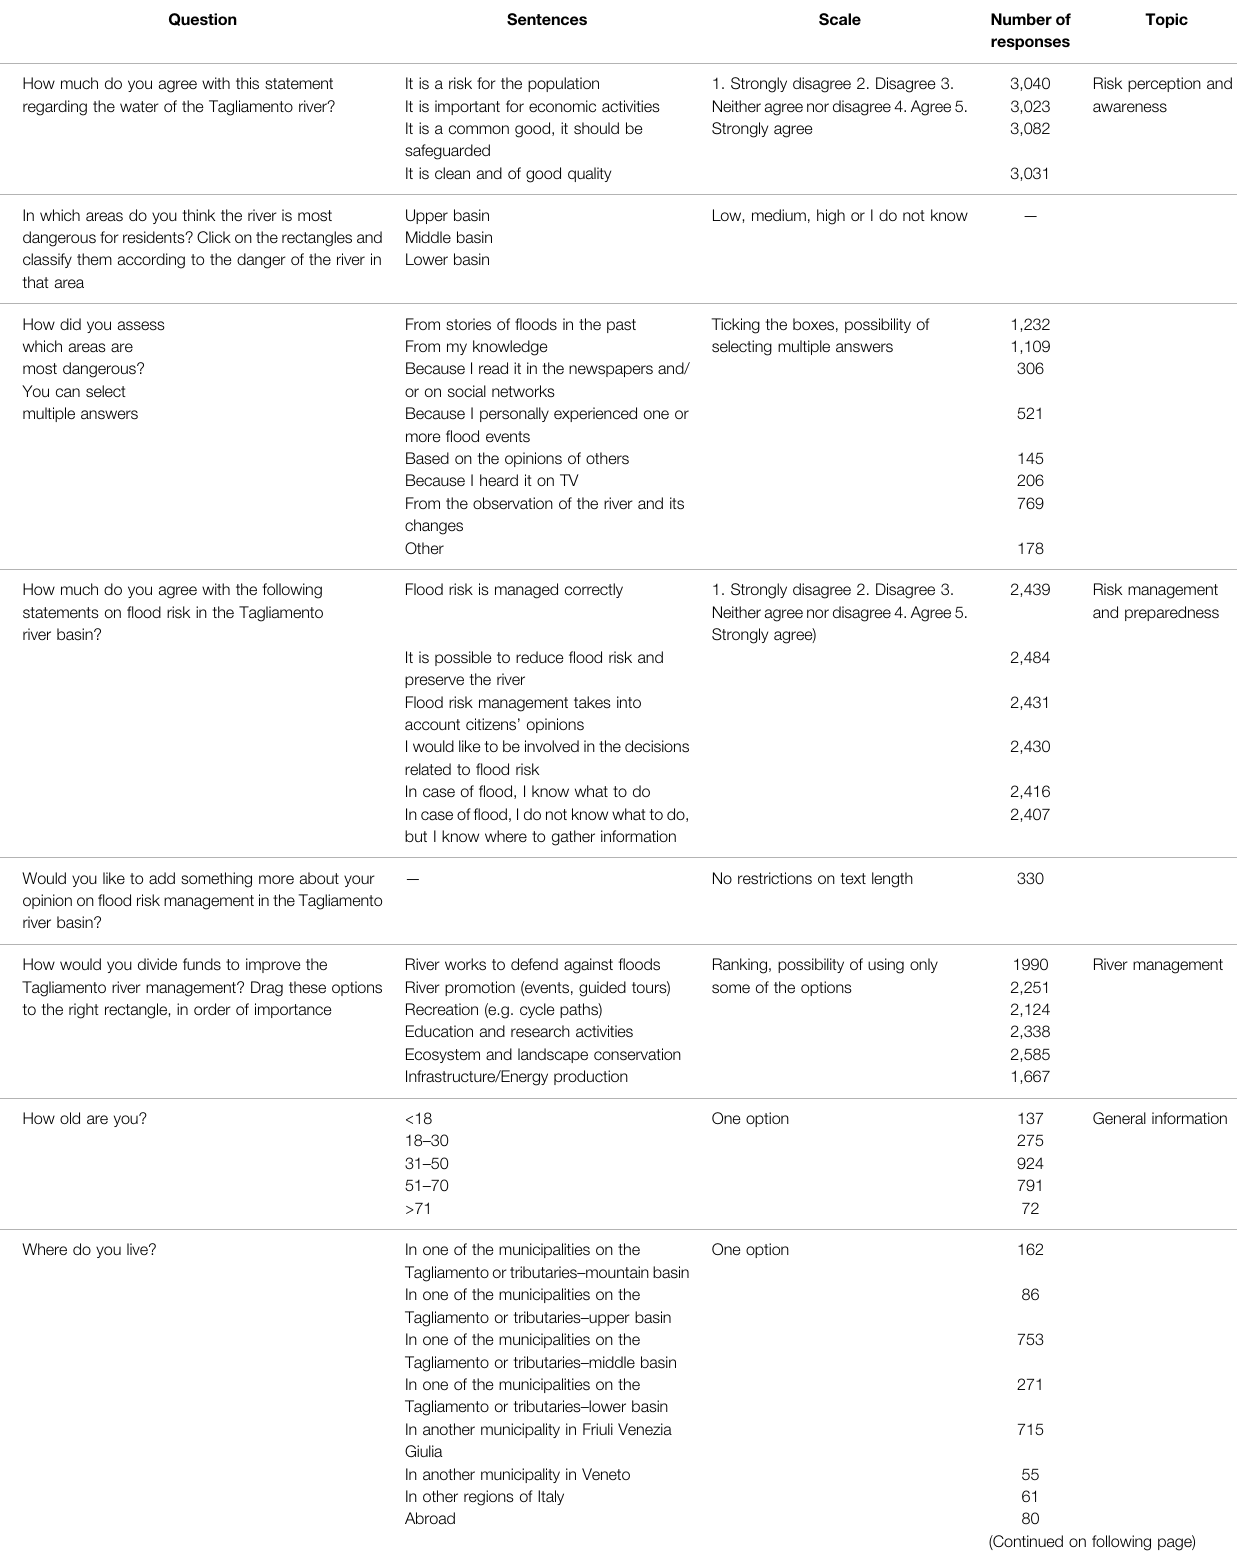
TABLE 1 | The questions of the questionnaire, including question ID used throughout the article, question and sentences as formulated in the questionnaire, scale used, number of responses, and